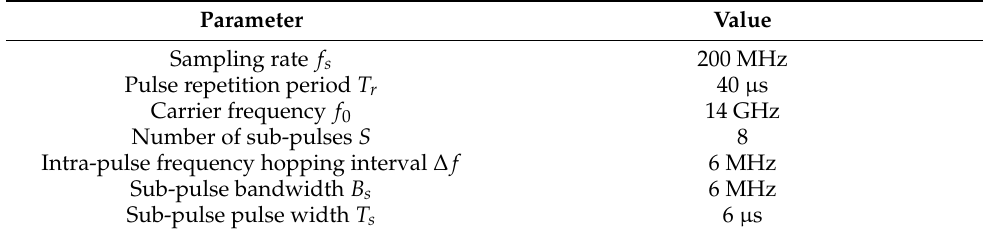
Table 1. Parameters of the intra-pulse frequency agile